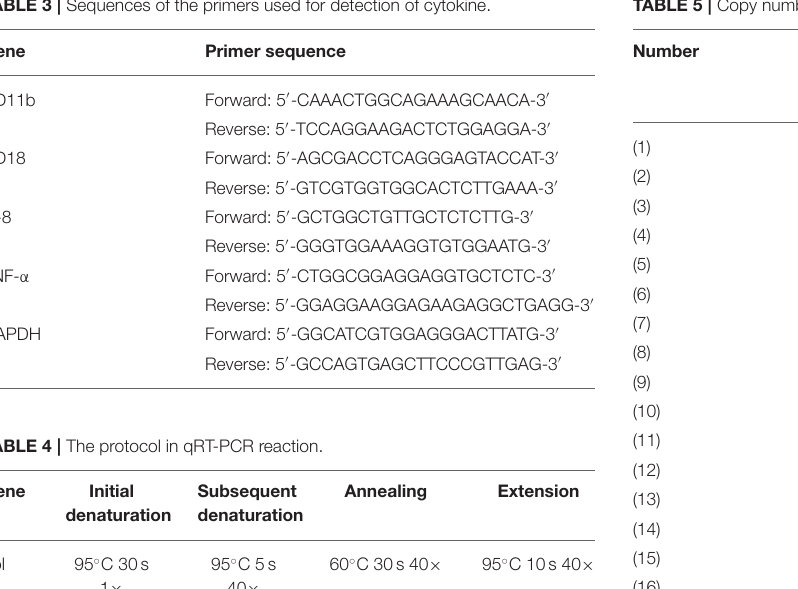
TABLE 5 | Copy number of BLV positive bovine